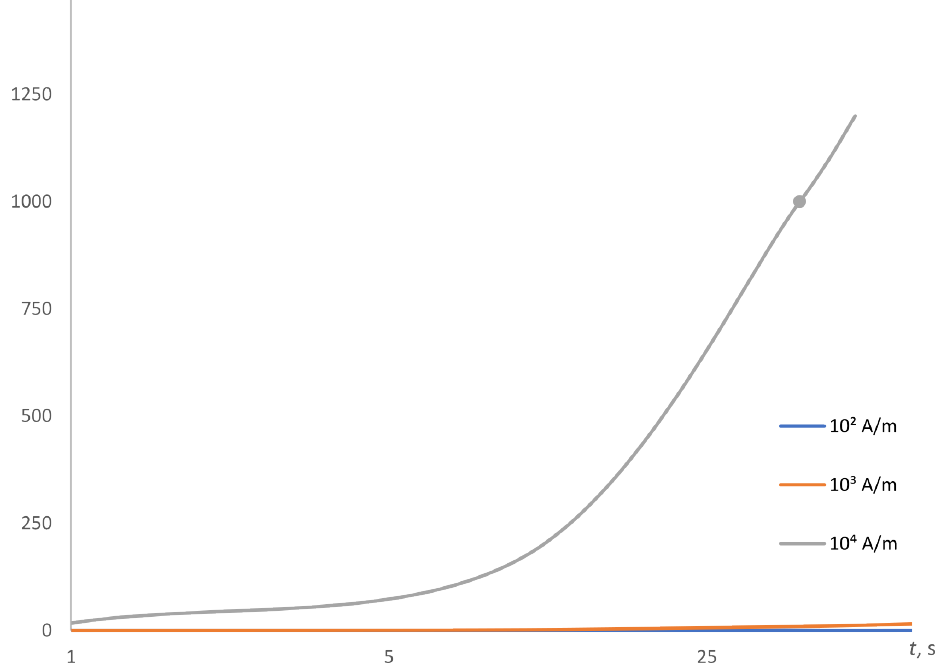
Figure 5. Temperature dependence on strength H 0 with different values of time duration of inductive heating NEMF t i